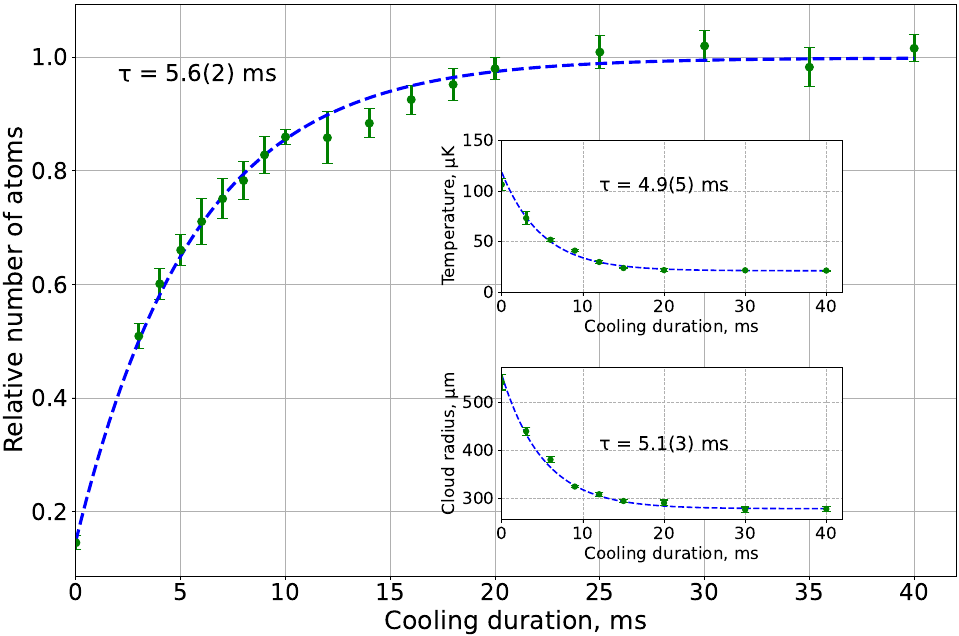
Figure 4. Number of atoms recaptured in broad 506.2nm MOT. Insets: temperature and cloud radius vs. 2nd-stage MOT cooling duration. Dashed lines represent the exponential function fitting, with the characteristic time of the recapturing process being 5ms. ≈